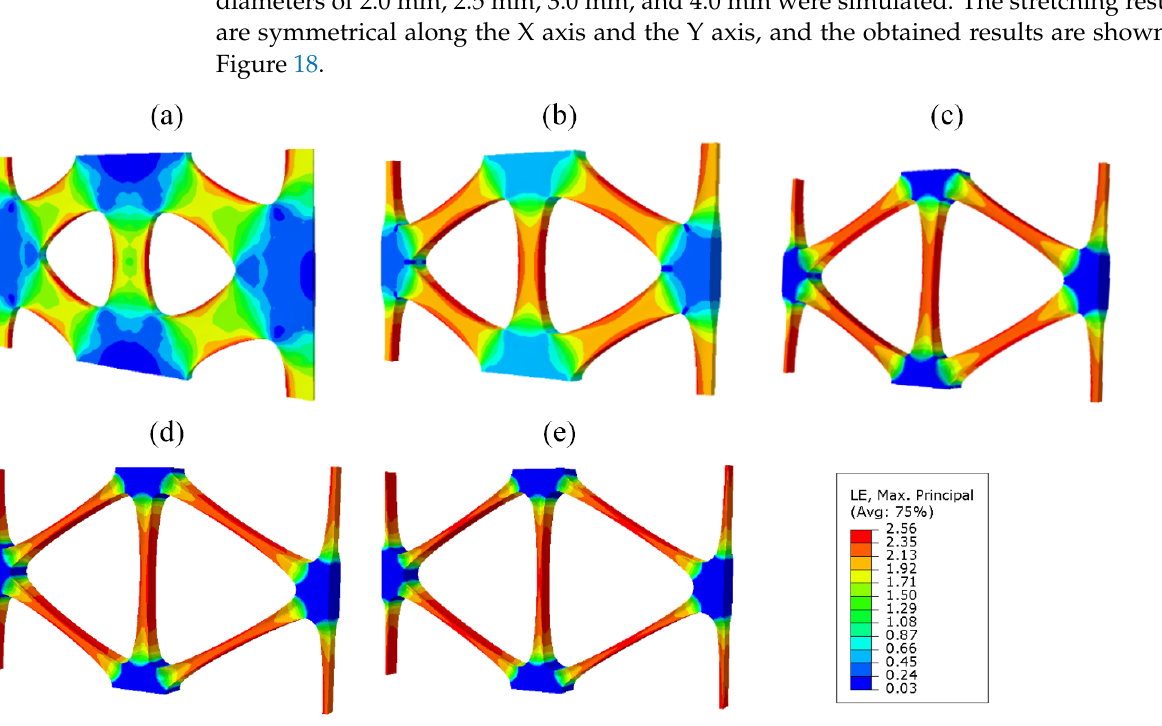
Figure 18. Simulation result of triaxial geogrid with different pre-punched diameters. ( a ) D = 2.0 mm, ( b ) D = 2.5 mm, ( c ) D = 3.0 mm, ( d ) D = 3.5 mm, ( e ) D = 4.0